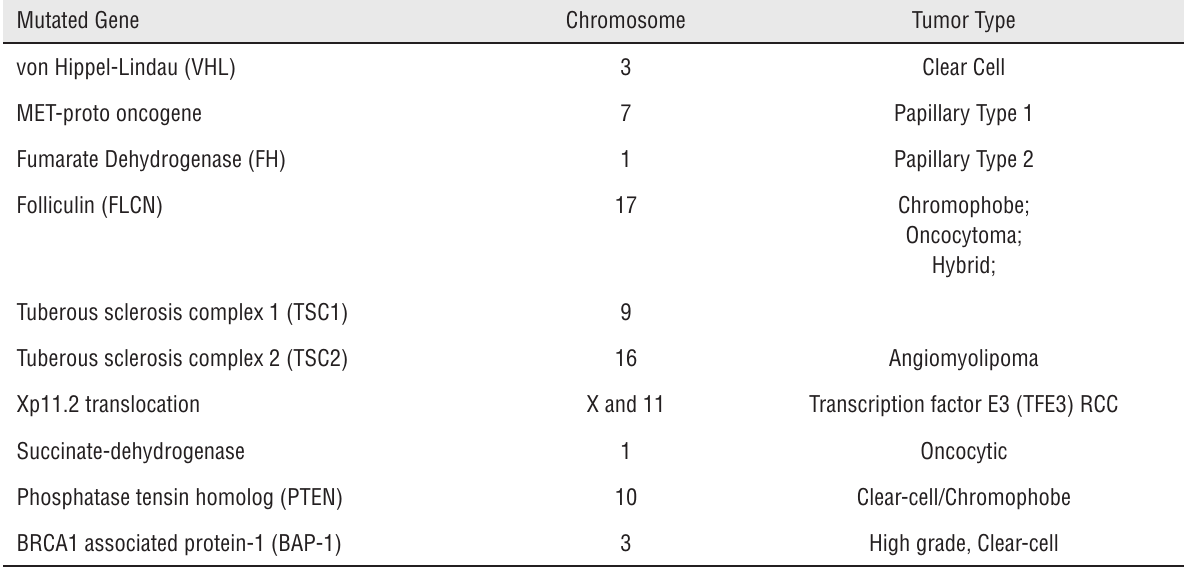
Table 1 - Renal cell carcinomas and genetic correlates (4-8), (10-12). Mutated